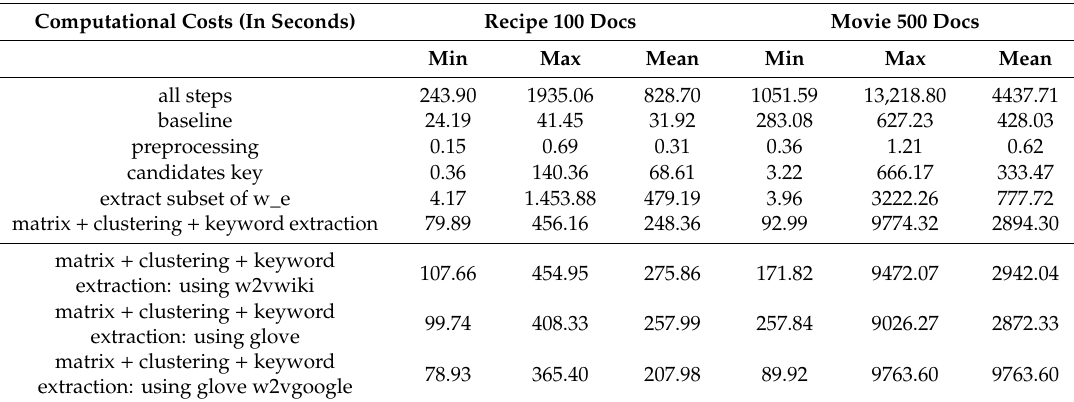
Table 6. Computational costs for the proposed